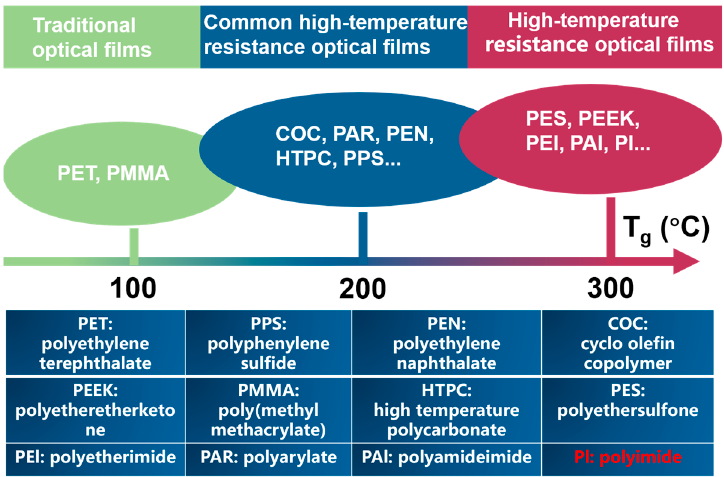
Figure 3. Classification of polymer optical films.